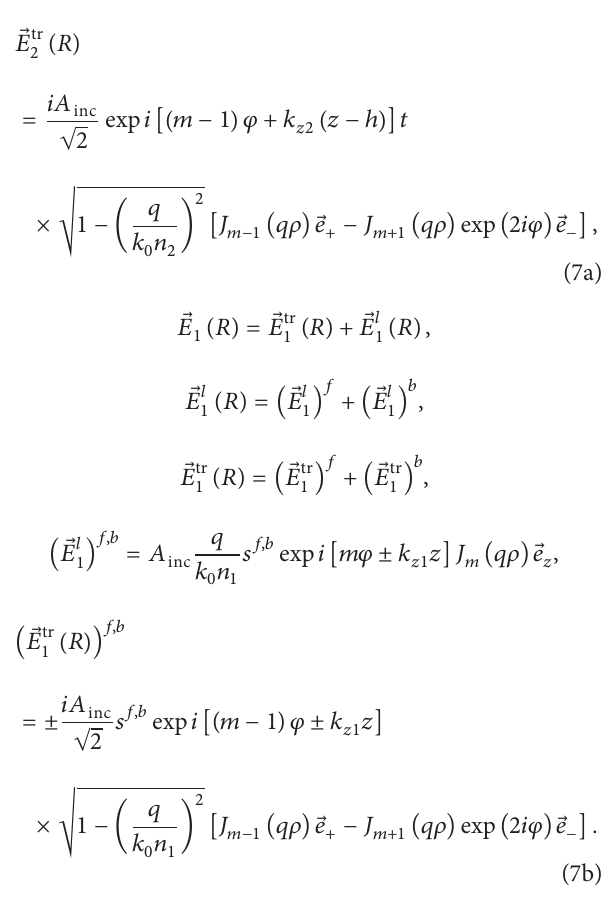
is the amplitude reflection coefficient; inc